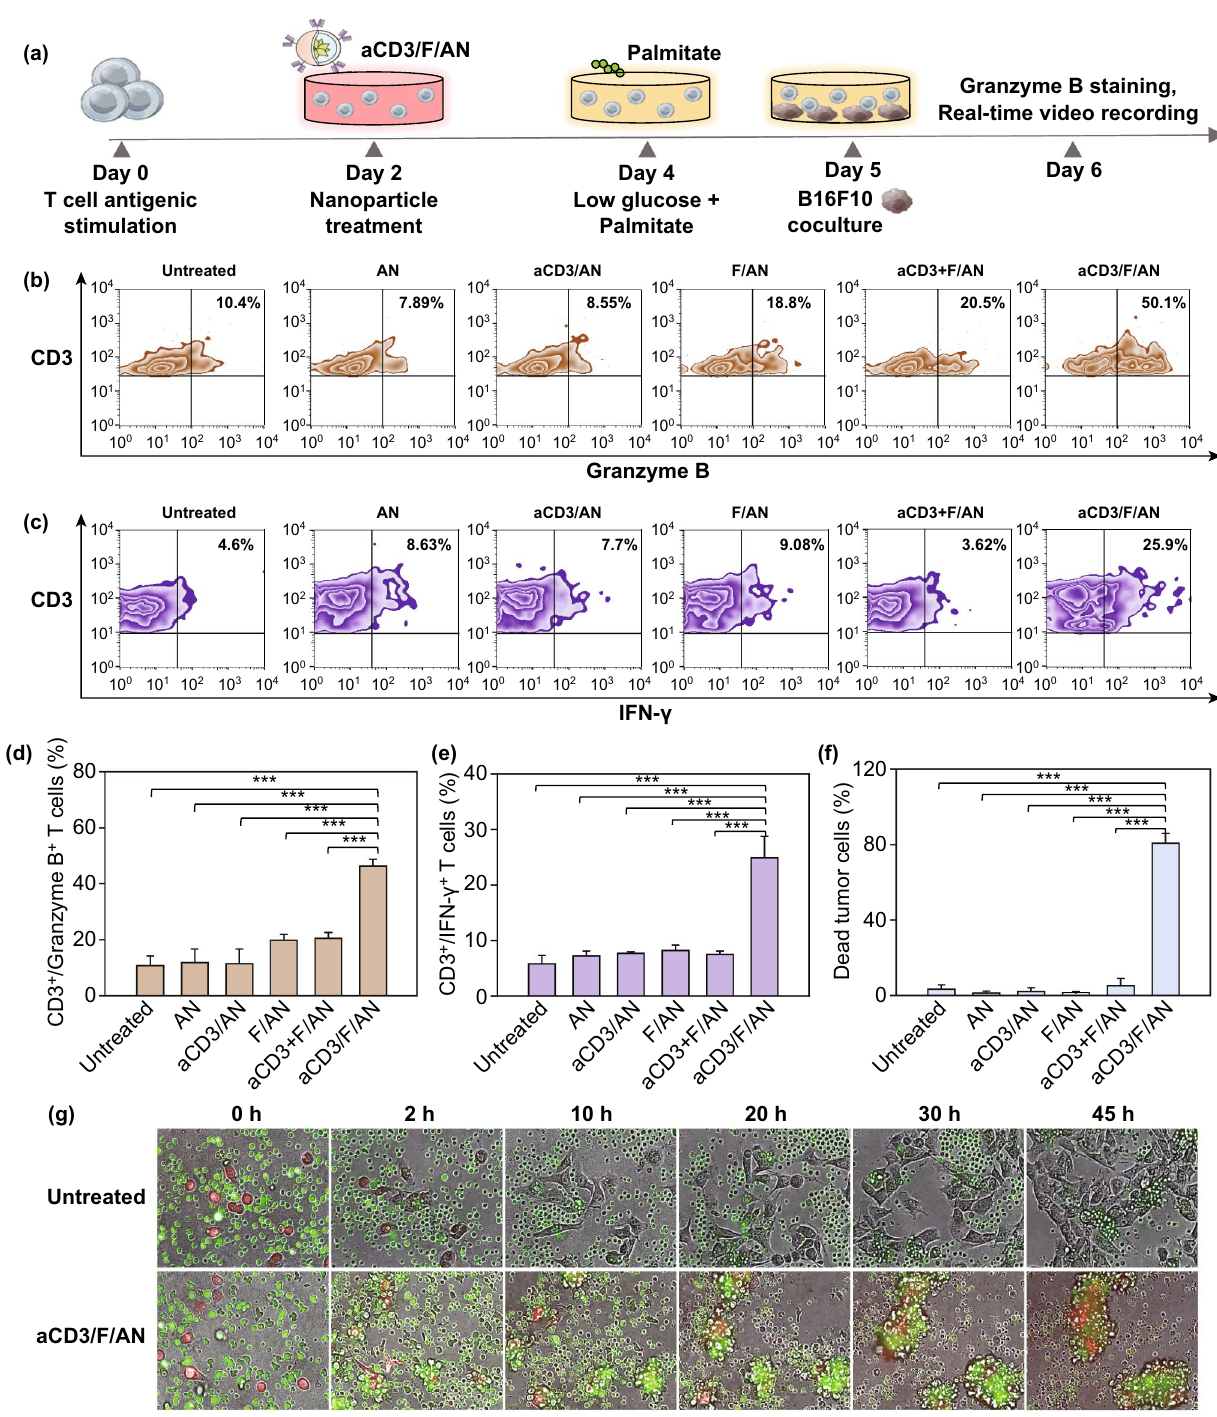
Fig. 7 In vitro anticancer activity of aCD3/F/AN‑treated T cells. T cells were treated with various nanoparticle preparations and co‑incubated with B16F10 cells under glucose‑limiting conditions in the presence of palmitate as a lipid source. a Illustration of the experimental scheme. b, c Flow cytometry data of T cells positive with granzyme B ( b ) and IFN‑γ ( c ). d, e The populations of T cells positive with granzyme B ( d ) and IFN‑γ ( e ) were quantified. (***P < 0.001). f Dead cancer cell population, quantified by flow cytometry (***P < 0.001). g Lysis of cancer cells by T cells, recorded in real time. Cancer cells were labeled with red fluorescent dye, whereas T cells were labeled with green fluorescent dye. Real‑ time video recordings of untreated T cells or T cells treated with aCD3/F/ANs are shown in Supplementary video S1 and S2,